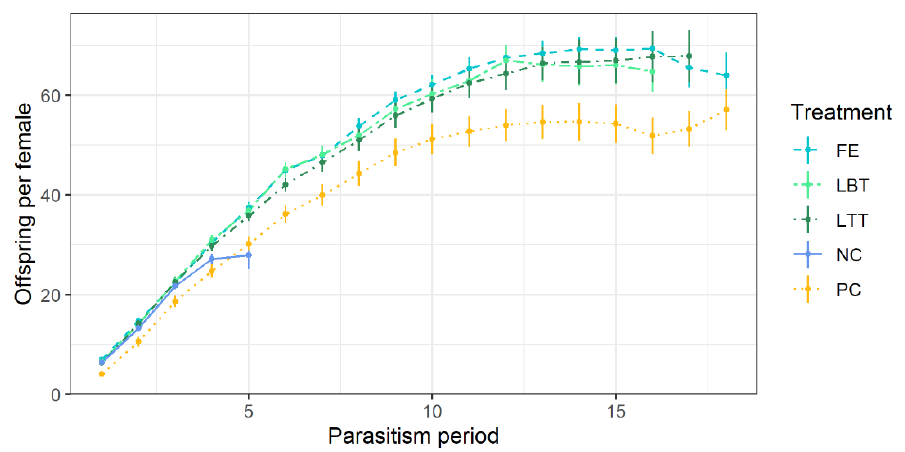
Figure 2. Cumulative number of offspring produced by female Trichopria drosophilae when provided with different diets (NC = water, negative control, PC = honey, positive control; flowers of FE = Fagopyrum esculentum , LBT = Lobularia maritima ‘Benthamii’, LTT = L. maritima ‘Tiny Tim’) and ten hosts (pupae of Drosophila suzukii ) for each parasitism period. N = 30 wasps per treatment. Parasitism period refers to 2.3 days on average. Solid dots with lines display mean ± SE.